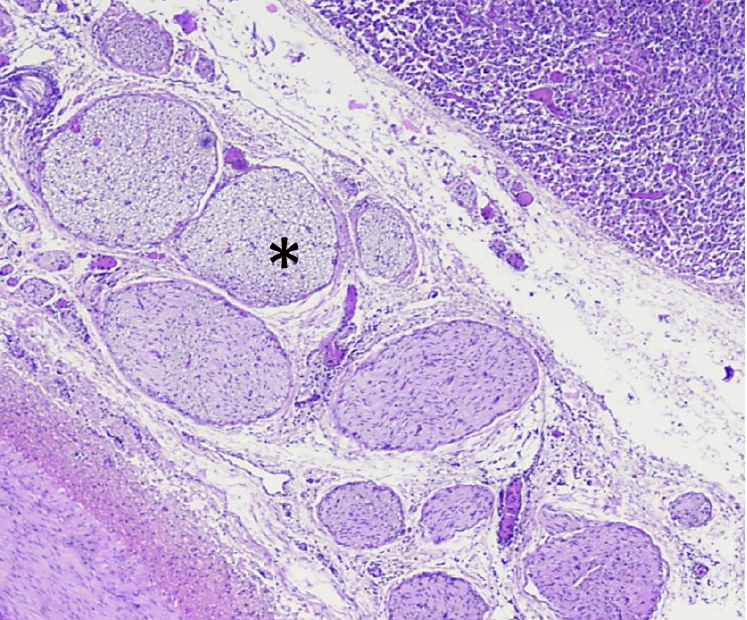
Figure 7. Histological examination of a typical example of the treated plexus nerve (location indicated by *) around the treated arteries. Hematoxylin and eosin stain; magnification ×200.